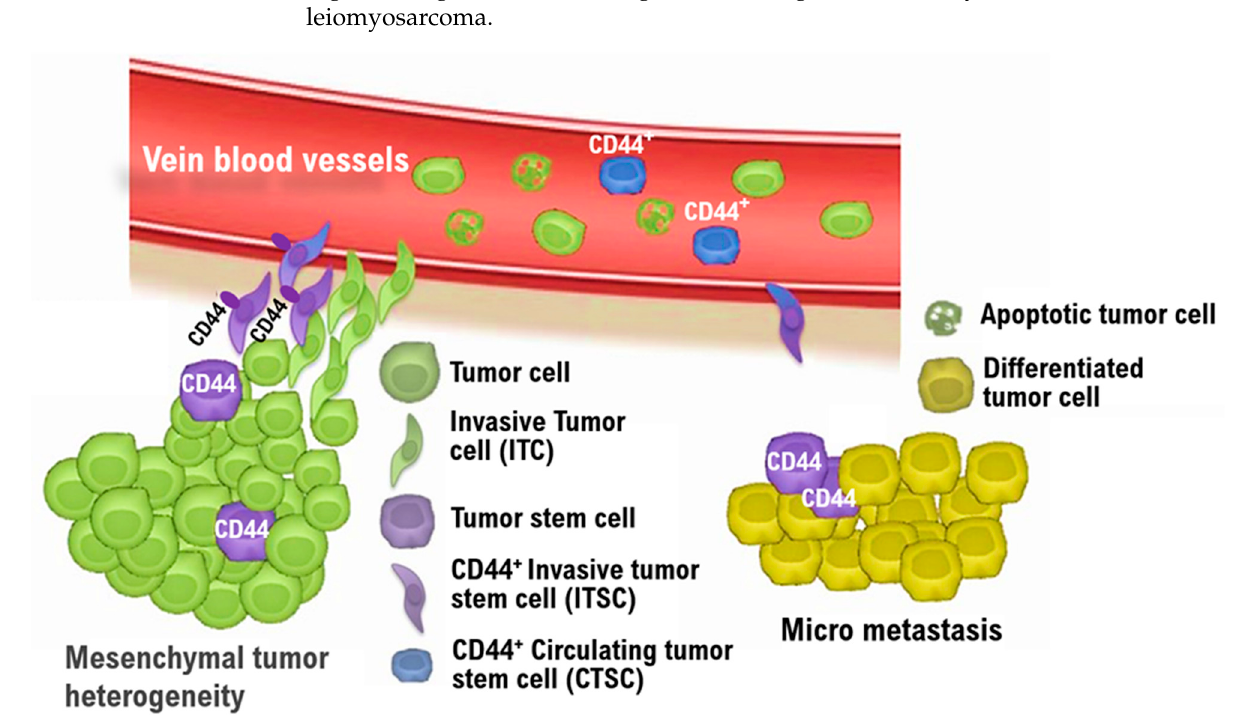
Figure 5. The invasion and metastatic process of uterine mesenchymal tumor stem-like cells. The nature of malignant tumors varies from patient to patient. Malignant tumor tissue comprises a heterogeneous cell population, containing many fibroblasts and tumor stem cells in addition to tumor cells. The heterogeneity of malignant tumor cells is one of the main reasons for the difficulty in treating malignant tumors. In particular, malignant tumor stem cells undergo distant metastasis and have resistance to antitumor agents. Understanding the oncological properties of malignant tumor stem cells contributes to the development of new targeted antitumor agents. The complex process of distant metastasis includes detachment, invasion of the tumor microenvironment, and shedding of invasive tumor cells (ITCs) and CD44-positive invasive tumor stem cells (ITSCs) into the bloodstream (intravasation). The majority of ITCs relate to differentiated cancer cells with low tumorigenicity and instead undergo apoptosis. However, CD44-positive ITSCs bear cancer stem cell features, i.e., CD44-positive circulating tumor stem cells (CTSC), survive in the circulating blood, escape from immune surveillance, and go home to secondary sites, extravasate, and ultimately form distant metastatic lesions. The application of cytotoxic drugs for ITSCs and/or CTSCs, such as celecoxib, greatly reduces the incidence of tumor metastases and tumor recurrence [35]. ITC: Invasive tumor cell, ITSC: Invasive tumor stem cell, CTSC: Circulating tumor stem cell.